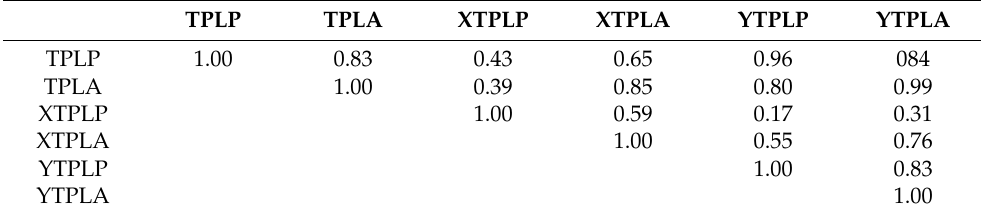
Table 5. Correlation results for the total path lengths (33 subjects).